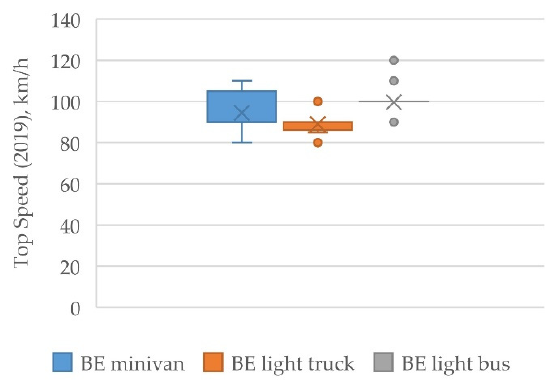
Figure 9. Top speed distribution of the various BELVs.